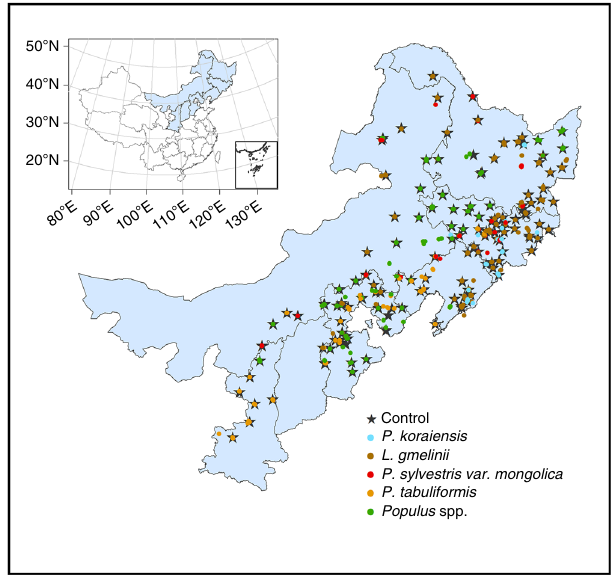
Fig. 1 Location of the study region in China and the study plots. The pentagrams represent the control plots and the cycles of different colors represent different planted tree species at each plot. The inset shows the location of the study region in China. This map was created in ArcGIS